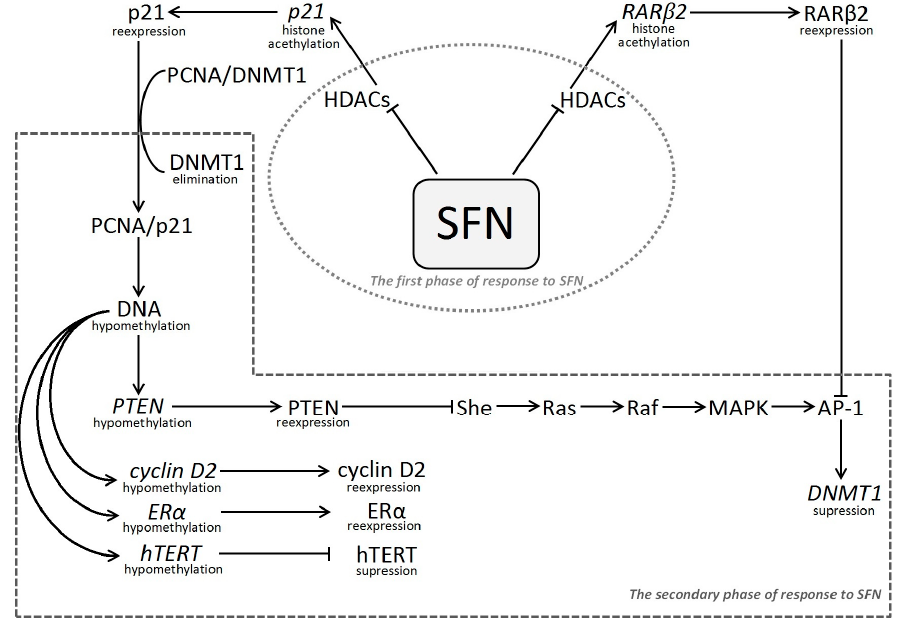
Figure 1. Schematic presentation of proposed molecular epigenetic mechanism of sulforaphane’s action including interdependence between histone modification and DNA methylation.